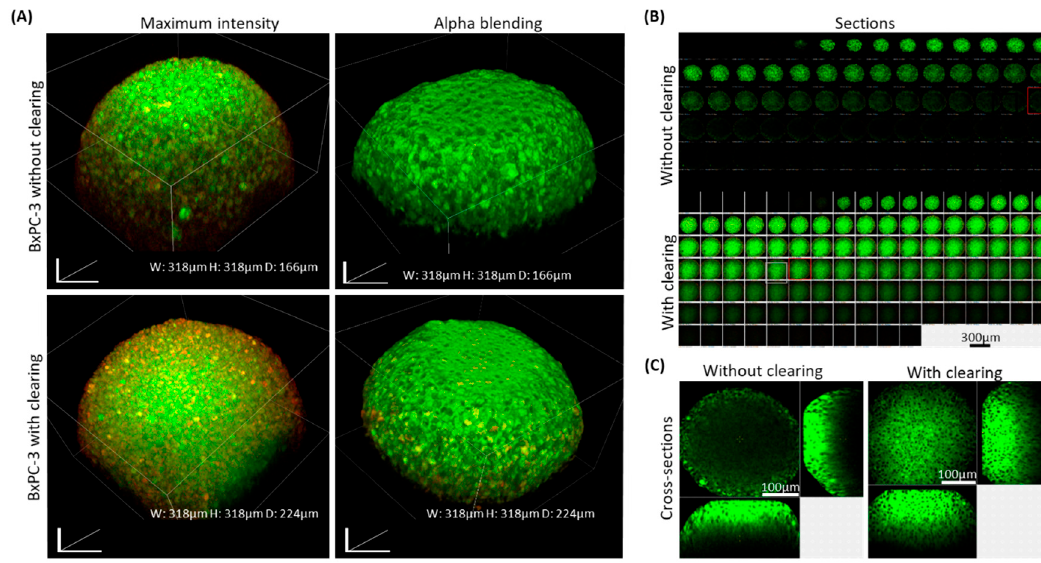
Figure 2. BxPC-3 spheroids with and without clearing treatment prior to imaging. BxPC-3 spheroids comprised of 10,000 cells were fixed and permeabilized 72 h after preparation. Spheroids were stained with Coumarin-6 (green) and DiD (red). ( A ) 3D projection imaging was performed with and without 85% glycerin clearing treatment prior to imaging. ( B ) Optic sections carried out in 2-micron steps of cleared and uncleared BxPC-3 spheroids. ( C ) Cross-sectioning of cleared and uncleared spheroids performed in 112 µm depth from the top.